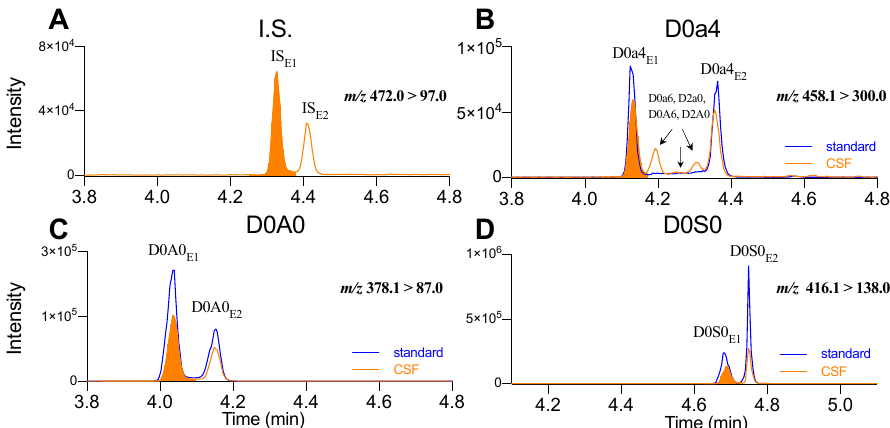
Figure 2. Representative chromatograms of internal standard and disaccharide peaks from enzymatically digested CSF sample of an Ids KO mouse in a single run. ( A ) internal standard (I.S.) ∆ 4UA-2S-GlcOEt-6S, ( B ) D0a4, ( C ) D0A0, and ( D ) D0S0. Each species shows two epimers designated as E1 and E2. Shaded orange peaks are the E1s that were used to represent the species for quantification. Blue traces are the authentic standards in a separate run for D0a4, D0A0 and D0S0, respectively. LC-MS conditions refer to experiment section.